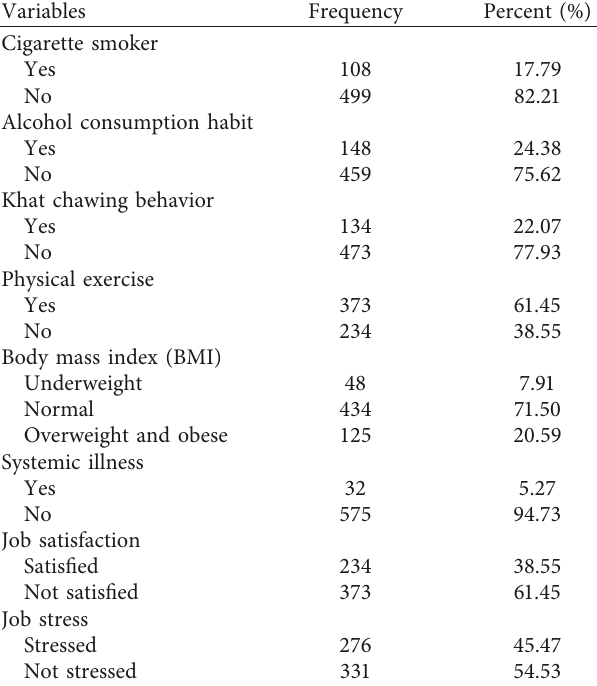
Table 2: Behavioral and psychosocial characteristics of teaching staff working in the University of Gondar, Ethiopia, 2021 ( N � 607).